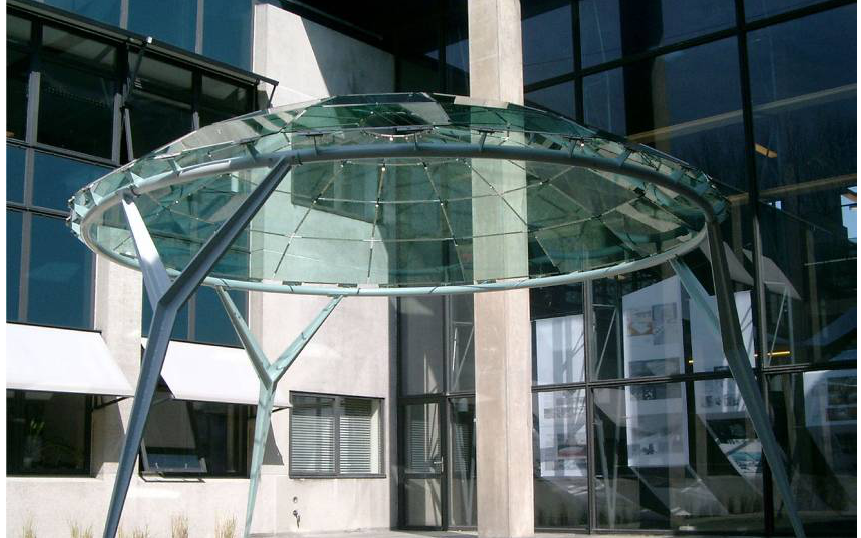
Figure 2: The all-glass dome outside of the former Bouwkunde